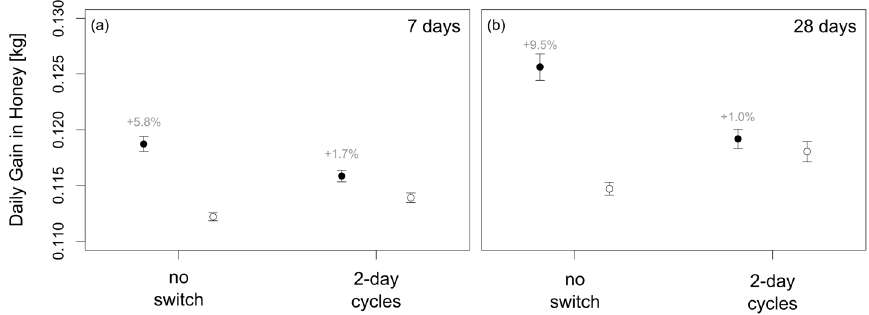
Figure 3. A comparison of foraging success measured as mean daily gain in honey (means ± s.e.) under the absence of costs to spatial information transfer (SI) and with SI, or no spatial information transfer (NI). The switching between SI and NI treatments masks the benefit of SI even if there are no costs to SI (solid circle: SI, open circles: NI).